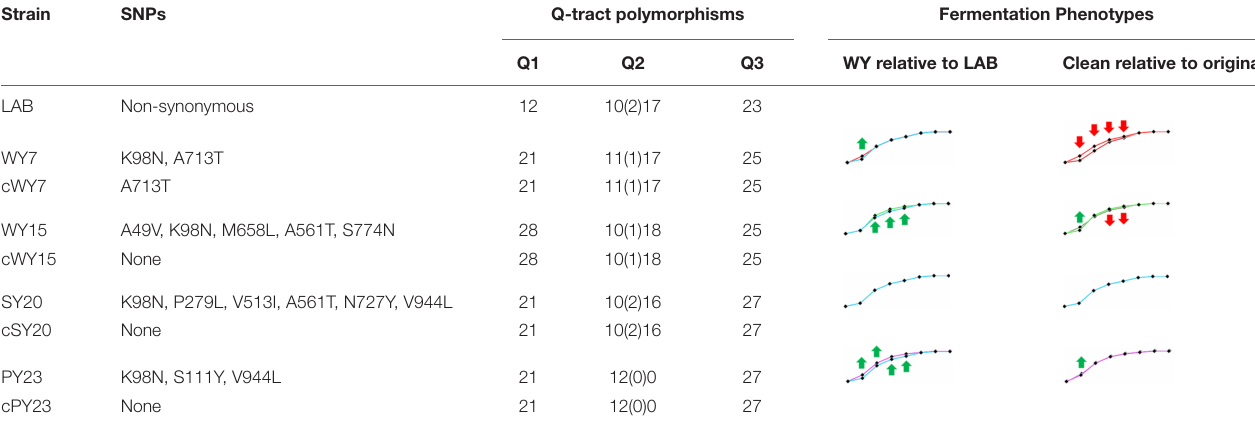
TABLE 7 | Cartoon Summary of MED15 alleles from Alcoholic Beverage Yeasts with and without Non-synonymous SNPs 1 . Strain SNPs Q-tract polymorphisms Fermentation Phenotypes